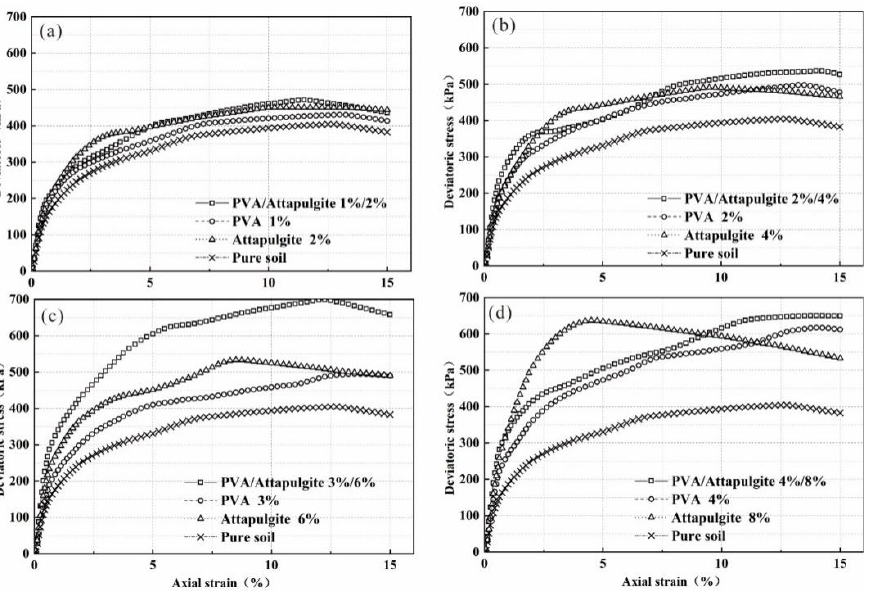
Figure 8. Deviatoric stress–strain curve under a confining stress of 100 kPa: ( a ) PVA content: 1%, attapulgite: 2%; ( b ) PVA content: 2%, attapulgite: 4%; ( c ) PVA content: 3%, attapulgite: 6%; ( d ) PVA content: 4%, attapulgite: 8%.